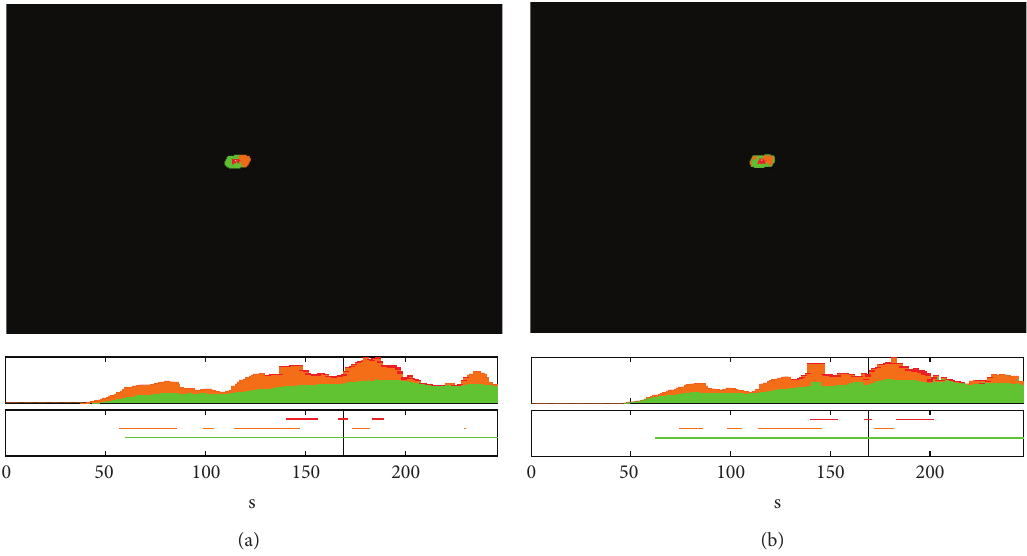
Figure 9: Fire alarms evolution for a fixed PFA with independent detectors (a) and fused detectors (b) in Ayora.